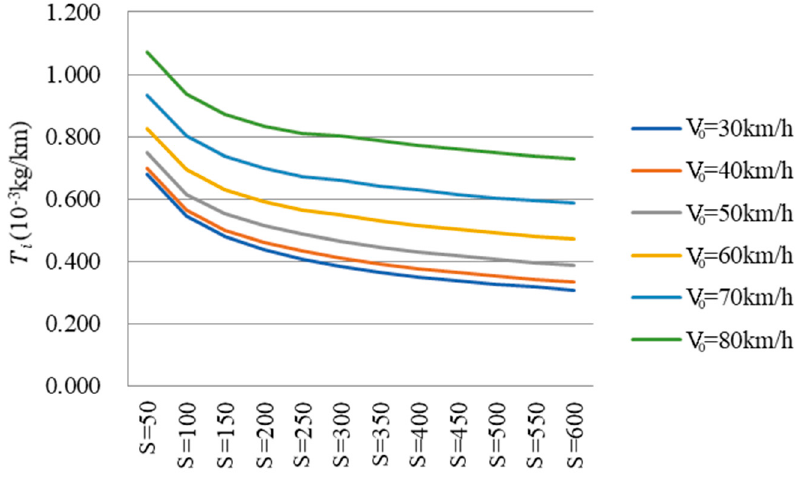
Figure 4. T i with a radius of 200 m. Int. J. Environ. Res. Public Health 2019 , 16 , x Figure 4. 𝑇 (cid:3036) with a radius of 200 m.